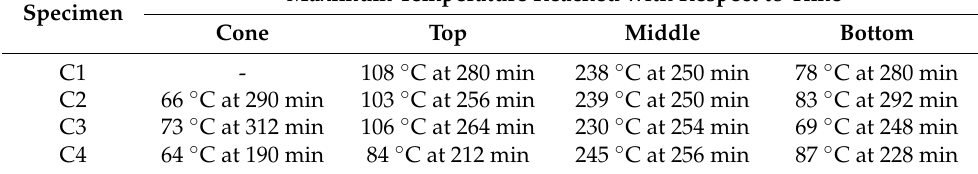
Table 2. Maximum temperature reached in the top, middle, bottom, and mimicked cone regions with respect to time.